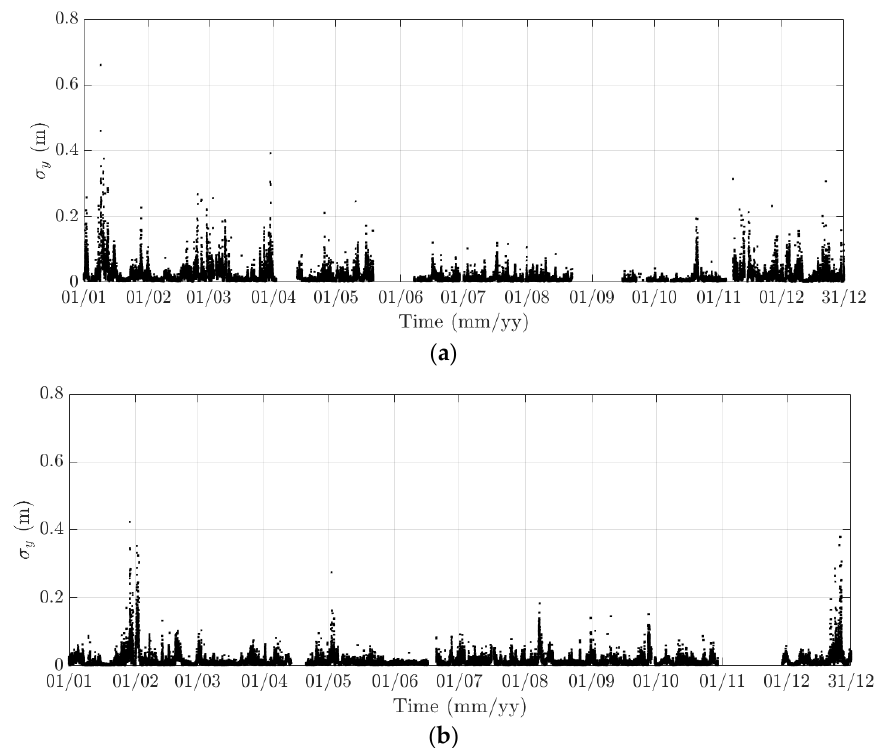
Figure 13. Variation of the 10 ‐ min standard deviation of the lateral response at the mid span of the FRB in ( a ) 2015 and ( b ) 2016.